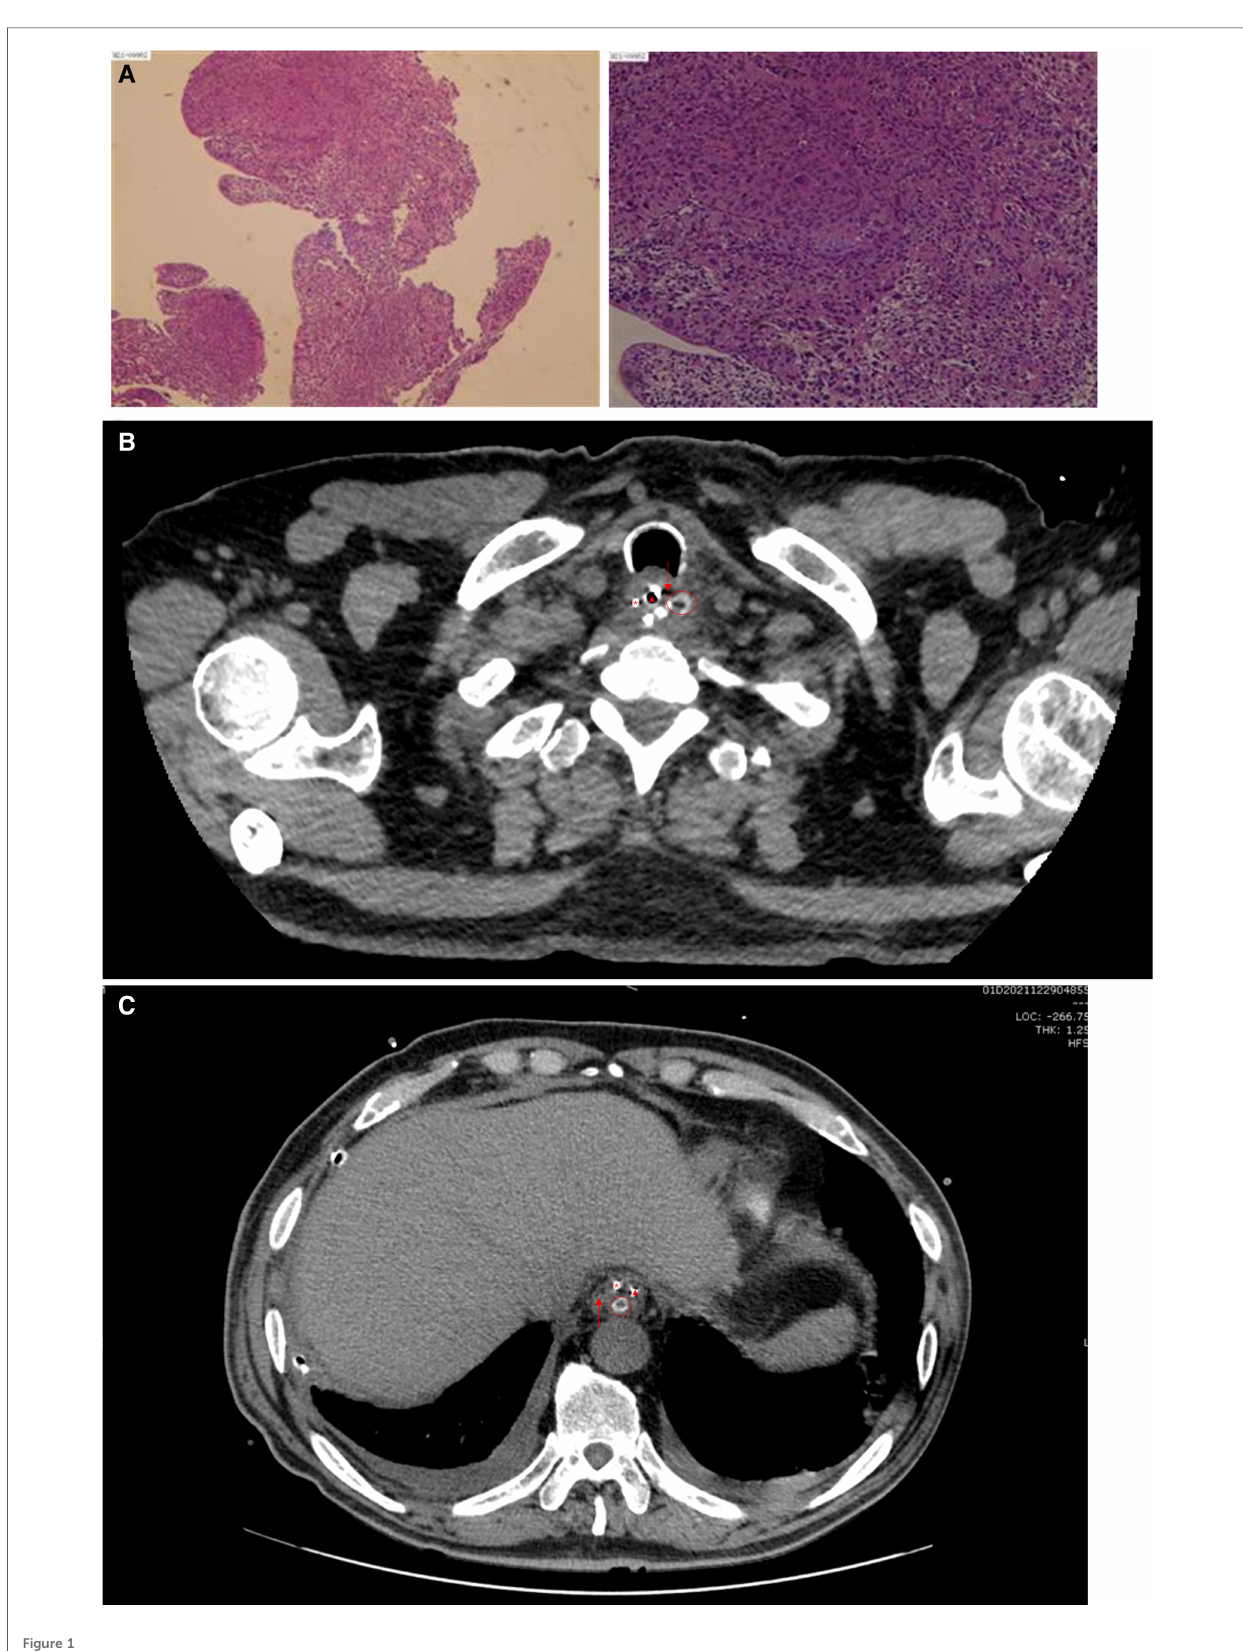
Figure 1 ( A ) Preoperative pathological pictures of the patient; ( B ) CT image on POD 7. Images showed that the drainage tube was located outside the esophageal cavity; ( C ) CT image on POD 37 showed that the cervical drainage tube went deep into the stomach. ○ , cervical drainage tube; ▴ , gastric tube; *, duodenal nutrient tube; ↓ , esophageal cavity; ↑ ,